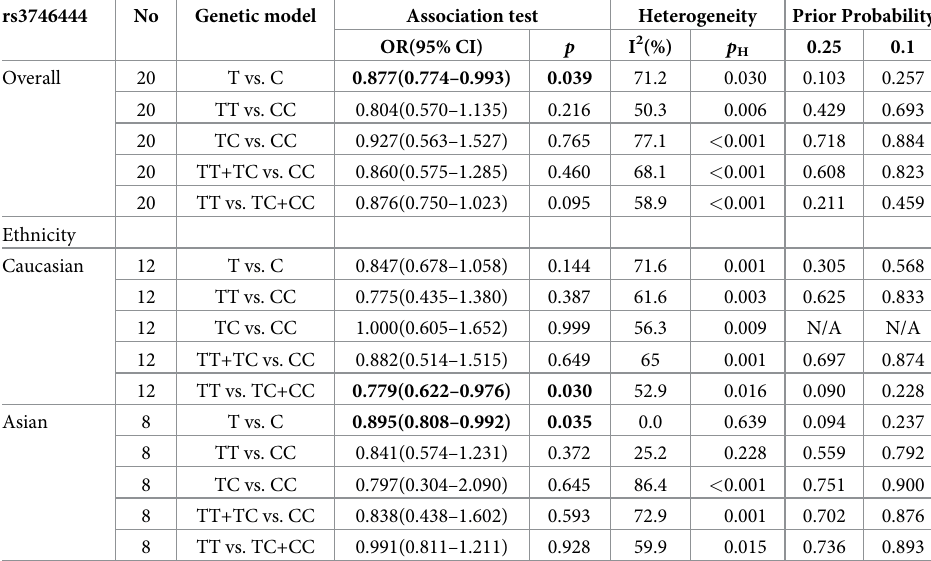
Table 2. Meta-analysis of miRNA-499 rs3746444 and autoimmune diseases.